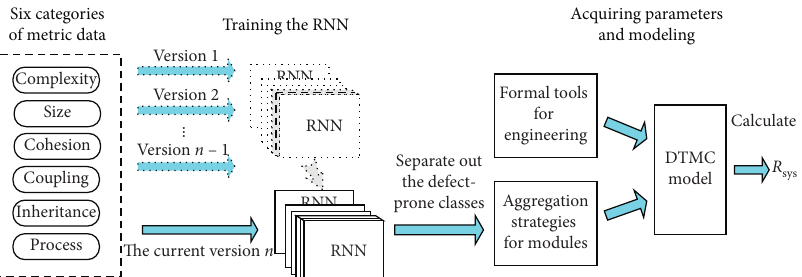
Figure 1: A framework of this study. The trained RNNs classify all classes of one module in the current evaluated version. A specified scheme receives class information and aggregates them to module reliability. The DTMC is used to calculate the overall reliability.